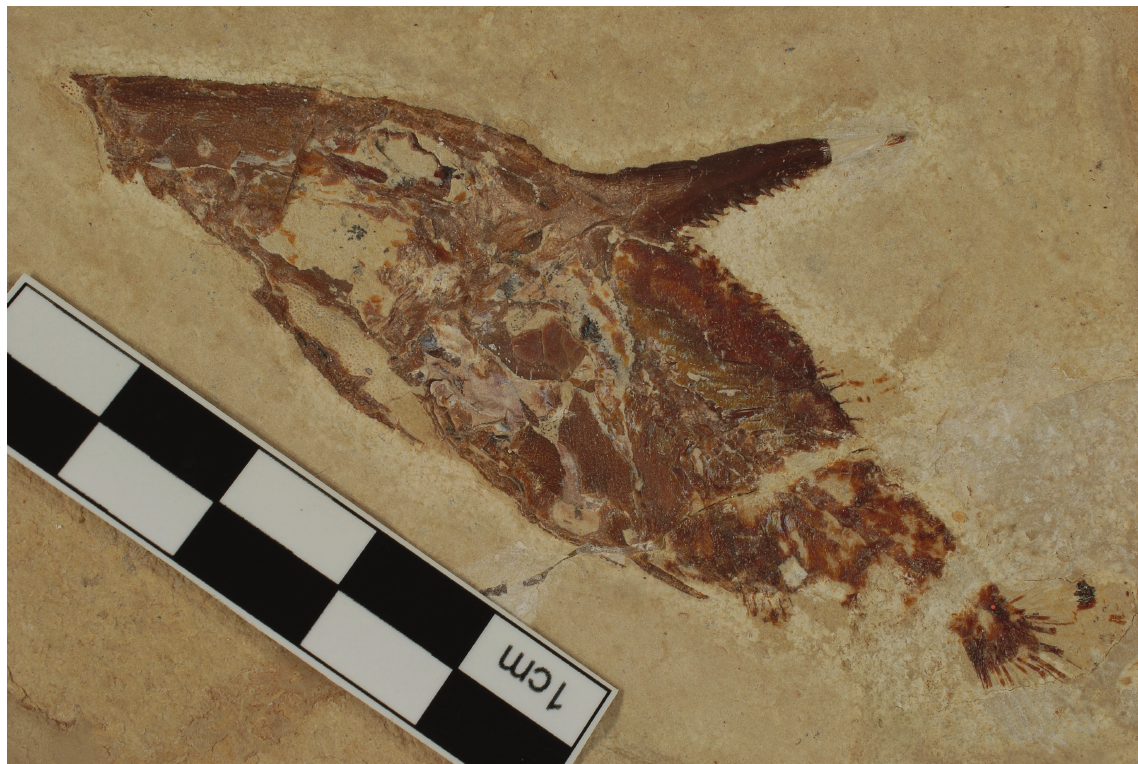
Fig. 3. Joinvillichthys lindstroemi (Davis, 1890). Sample CLC